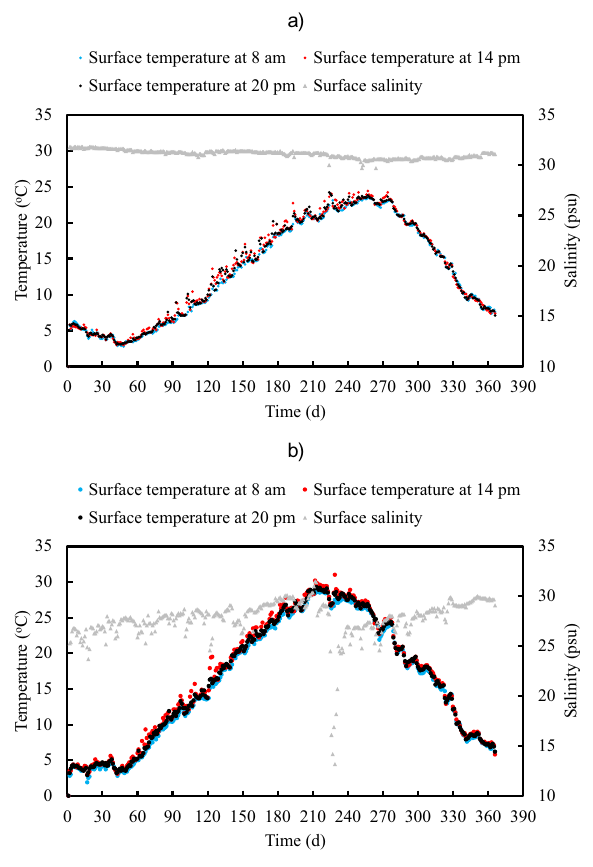
Fig. 6 Surface temperature and salinity records of the two observatories. a Data of Shidao Observatory, b Data of Lianyungang